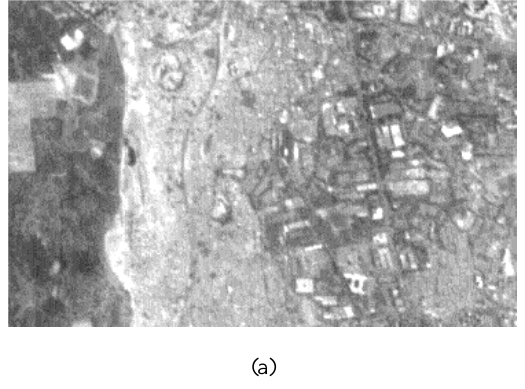
Figure 3: SIFT feature points (in red *) are superimposed on the left image